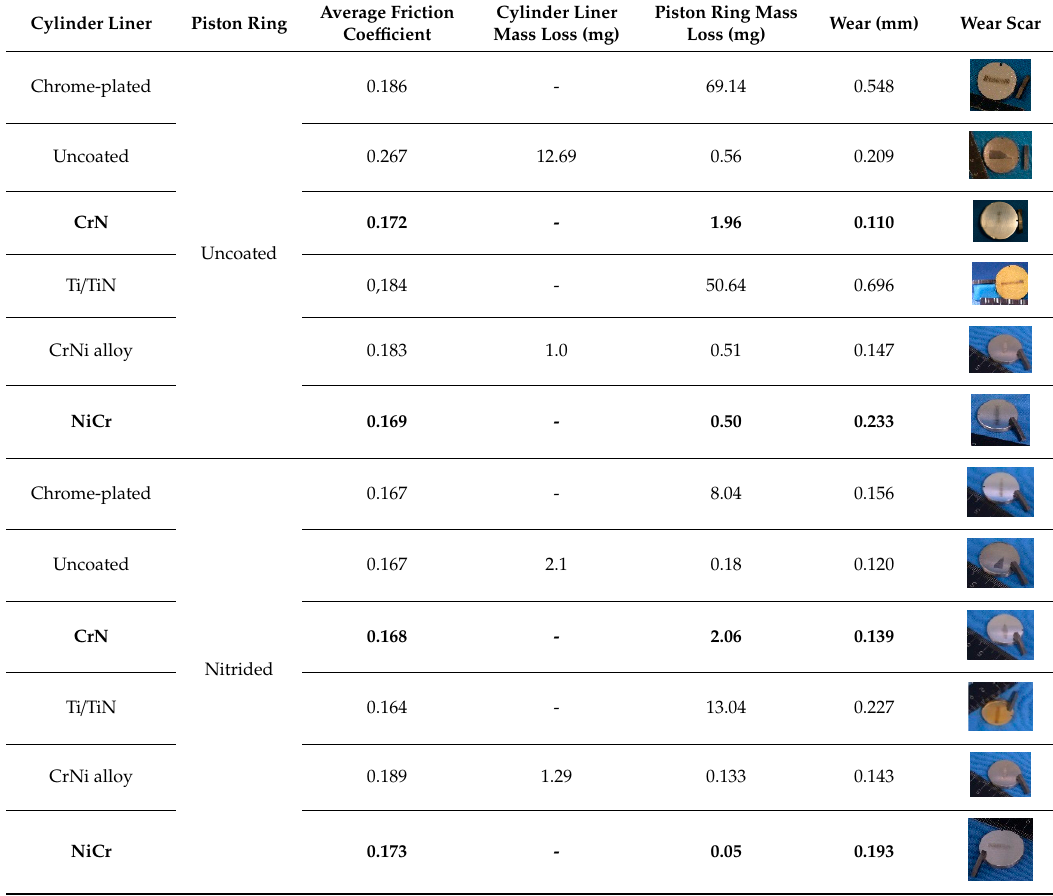
Table 2. Tribological test data for different combinations of cylinder liners and piston ring tribotests. Cylinder Liner